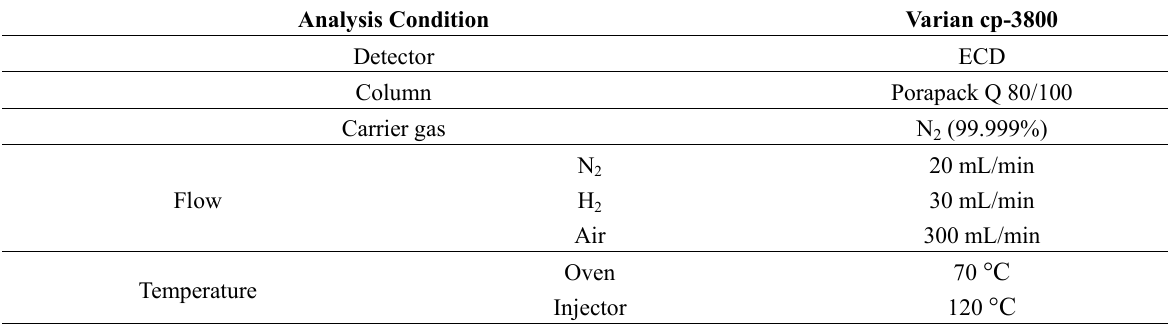
Table 2. Varian cp-3800